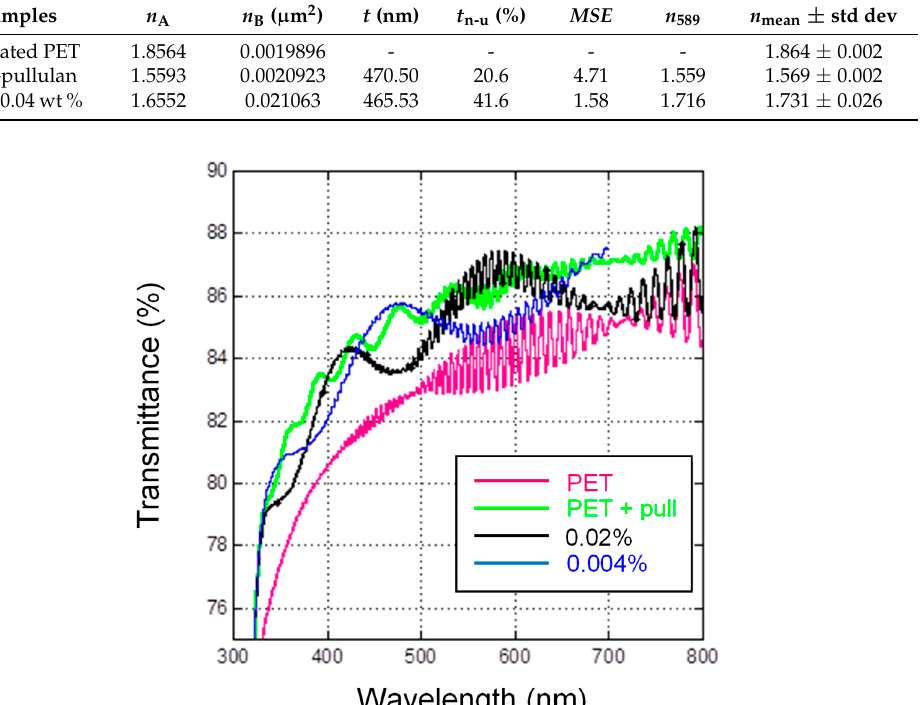
Figure 3. Transmittance spectra of bare PET, pullulan-coated PET, and PET coated with the nanocomposite coatings at different concentrations of mica (0.02 wt % and 0.04 wt %). The mean value of the transmittance measured in the visible region is reported in Table 3.